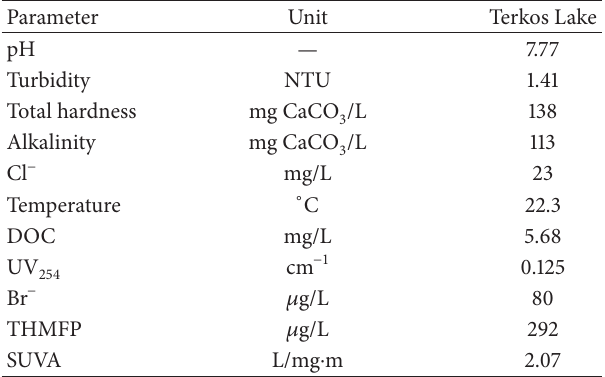
Table 1: Physicochemical characteristics of Terkos raw water sam-